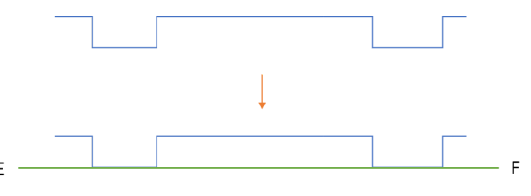
Figure 25. The digitized process of the possible cadastral line close to the road boundary. According to the obtained hand-held LiDAR point cloud, the possible cadastral boundaries between the townhouses and on the existing roads were digitized manually and joined in AutoCAD software to produce the results of the urban cadastral detail lines of the test area. The final results are shown in Figure 26.